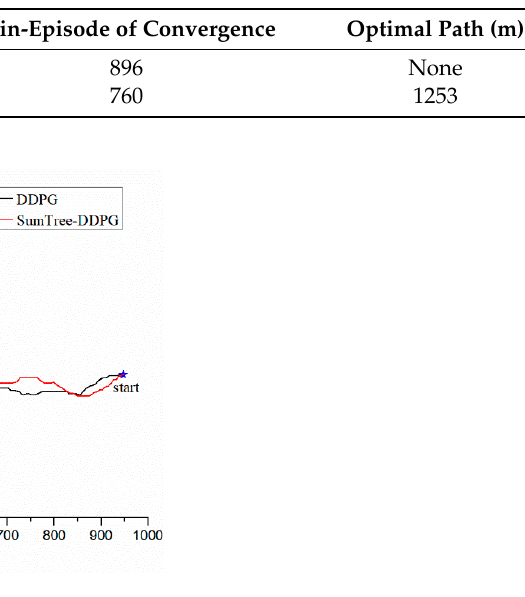
Figure 13. The optimized path of AUV in Environment 2.